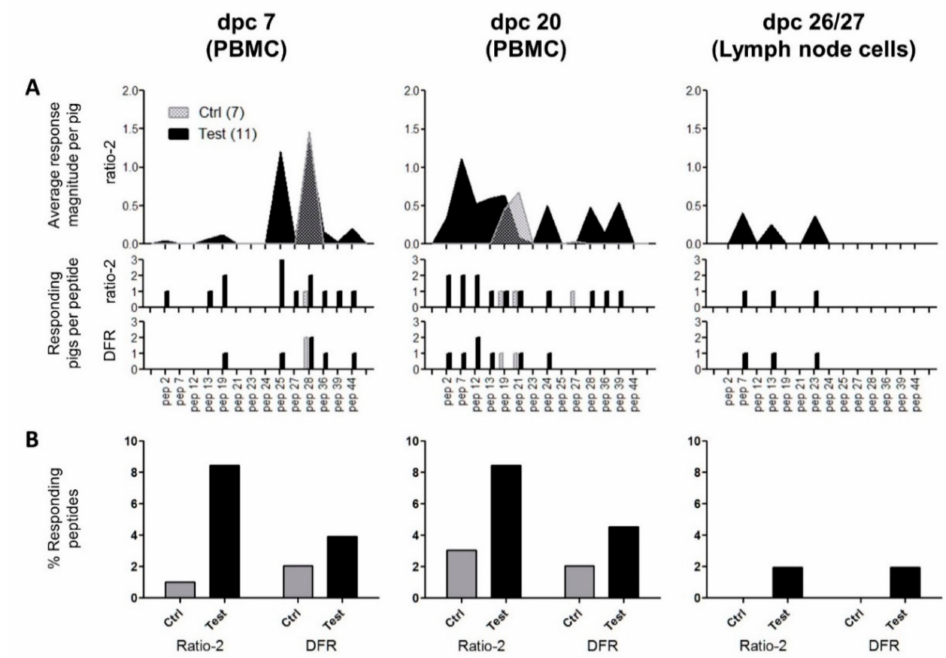
Figure 6. Summary of cell-mediated immune responses to peptides post-challenge. ( A ) The top panel represents the average magnitude of significant positive responses per pig according to the ratio-2 method; the middle panel represents the number of pigs/group with a significant positive response to the peptides according to the ratio-2 method; and the bottom panel represents the number of pigs/group with a significant positive response to the peptides according to the DFR method. Gray fill: control group (N = 7); black fill: test group (N = 11). The peptides are indicated on the x-axis with reference to the ID column in Table 2. ( B ) Relative comparison of responding peptides according to date, group, and statistical method. Each column was calculated using the formula: (responding peptides)/(tested peptides)/(number of pigs in the specific